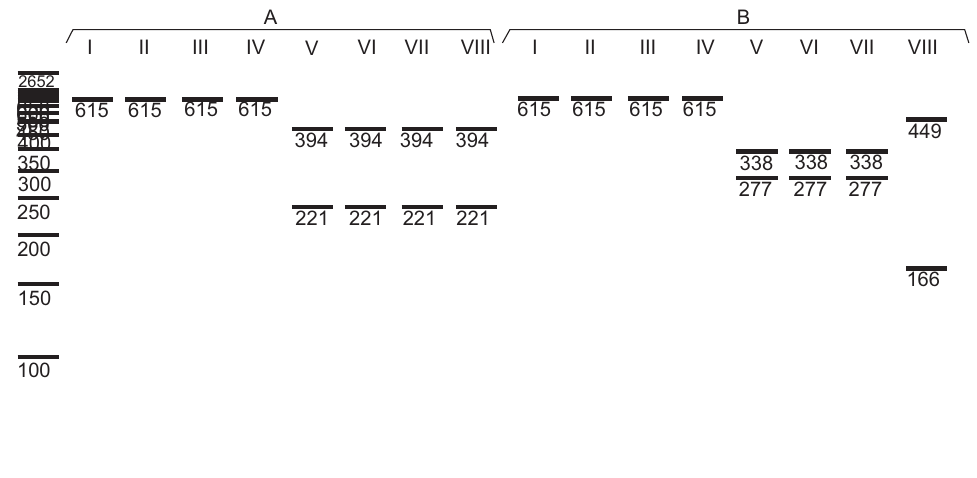
Figure 1. Virtual gel electrophoresis of Cytochrome b RFLP profiles for the four domestic species and for four manatee species under consideration. The Cytochrome b fragment is digested with BanI (394+221bp) (A), EcoRV (338+277bp or 449+166bp) (B) only in the T. inunguis , T. manatus , T. senegalensis and D. dugon . Identification of: (I) Bos indicus Linnaeus, 1758; (II) Capra hircus Linnaeus, 1758; (III)